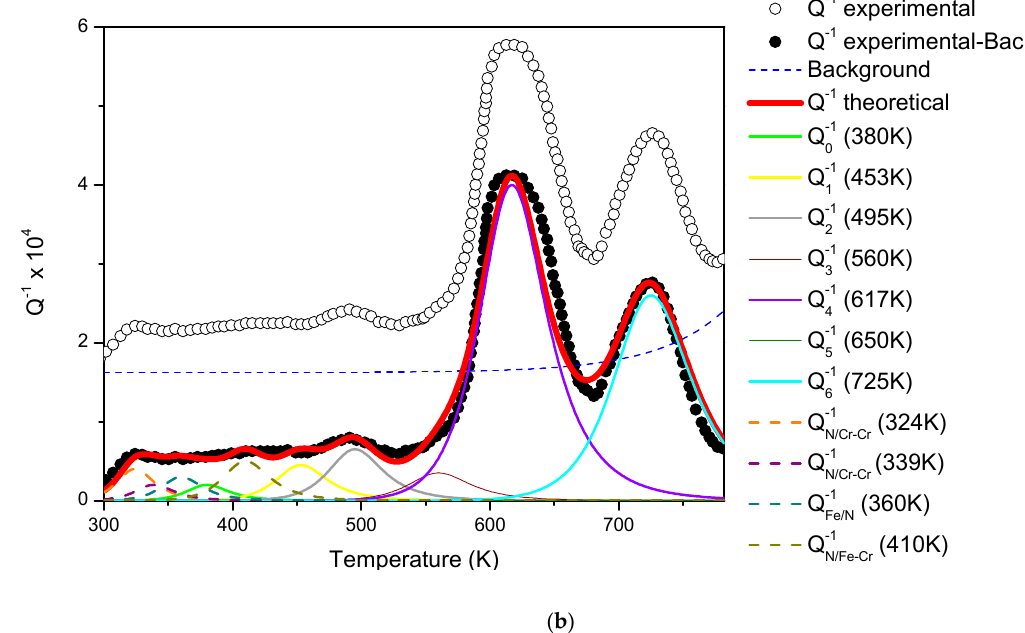
Figure 4. Fitting of the Q − 1 curves of the steel quenched from 1348 K with cooling rates of 3600 K/min ( a ) and 150 K/min ( b ). The best fit curve is the sum of the background curve, seven peaks corresponding to C–Cr associates with i values from 0 to 6, and four peaks due to N.